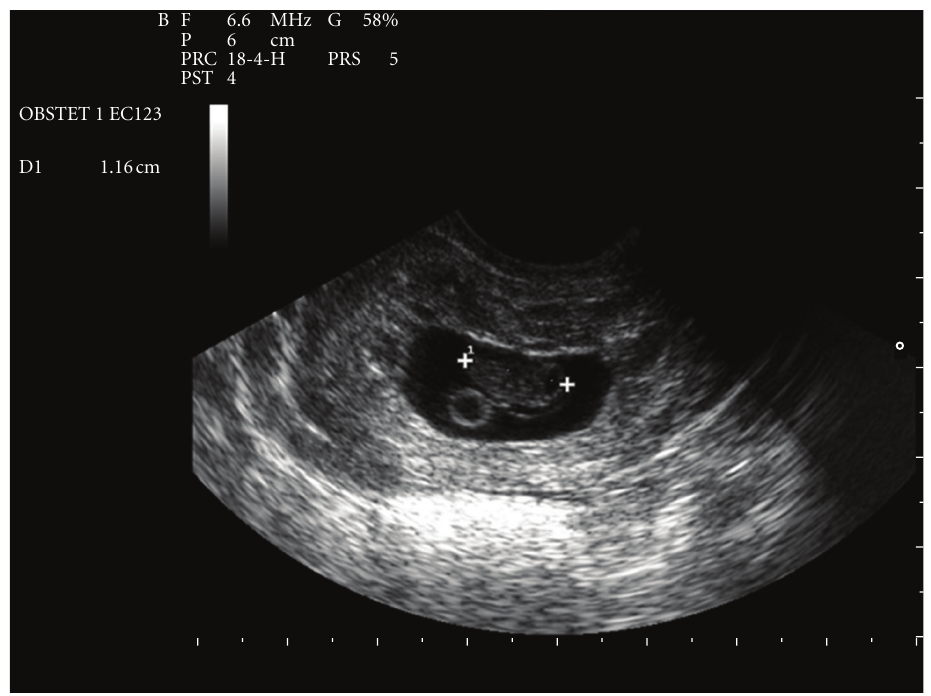
Figure 1: Transvaginal ultrasound image of the scar pregnancy crown-rump length 11.6mm with fetal cardiac activity.